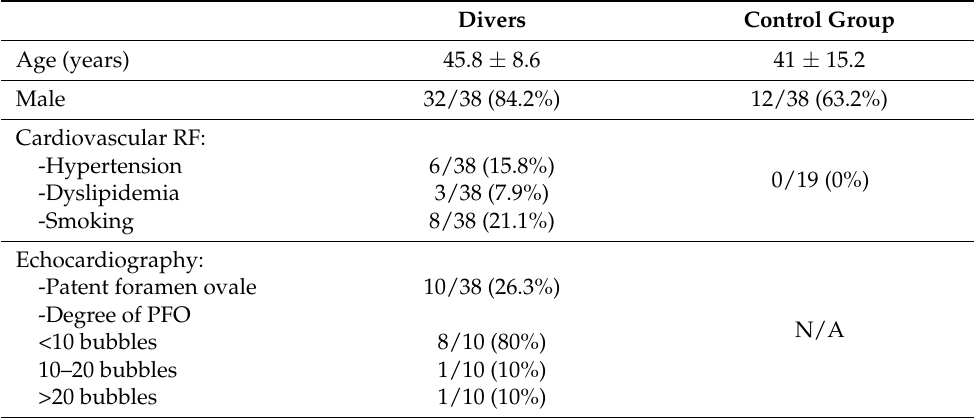
Table 1. Baseline